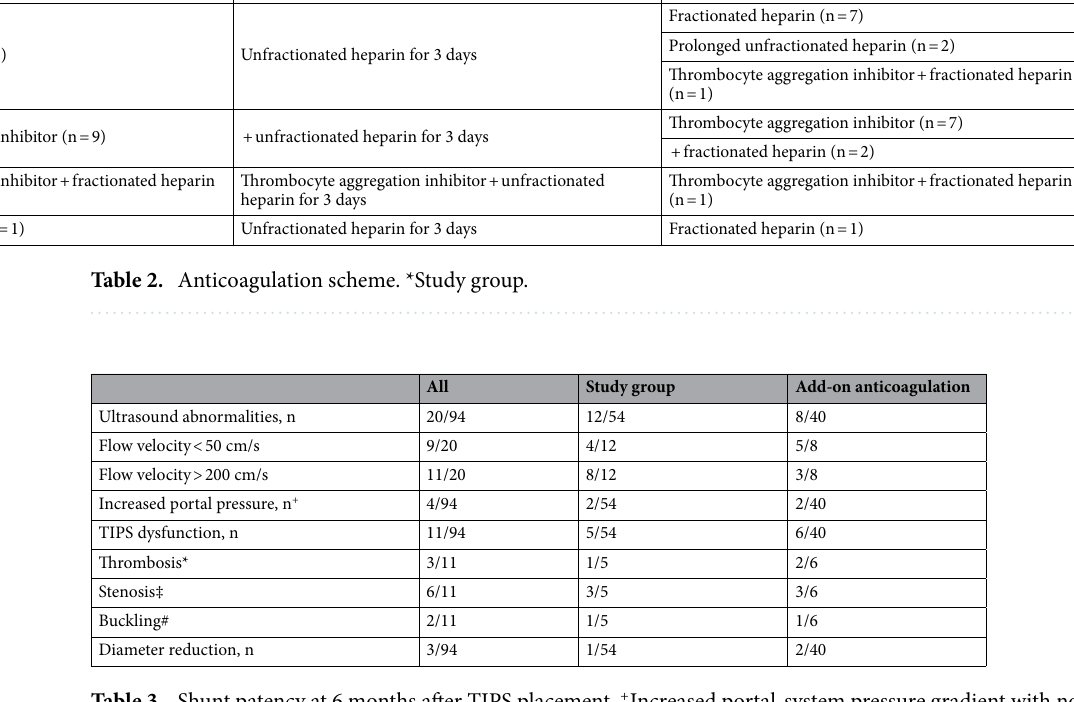
Table 3. Shunt patency at 6 months after TIPS placement. + Increased portal-system pressure gradient with no sign of stenosis, corrected by increasing the diameter of the TIPS by dilation. *Treated with recanalization and dilatation of the TIPS tract. ‡ Stenosis, because of intimal hyperplasia, corrected by dilation. # Corrected by the placement of an additional